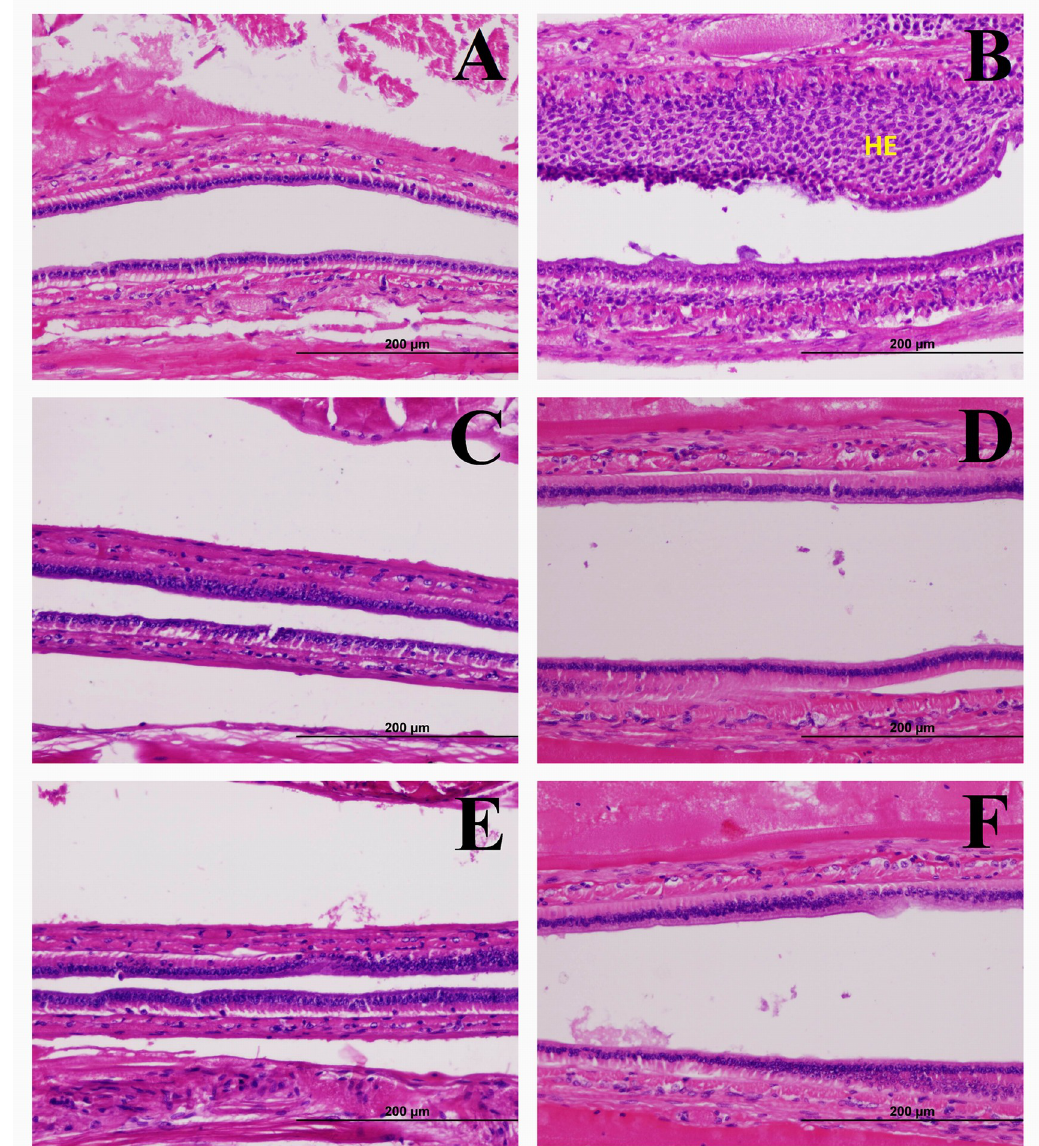
Fig 3. Effects of IQ extracts on histopathology of the intestine of the Vibrio parahaemolyticus -infected shrimp. Intestine of the shrimp fed the negative control diet ( A ), positive control diet showing hemocytic infiltration (HE) ( B ), IQ-E 200 mg/kg of feed diet ( C ), IQ-E 300 mg/kg of feed diet ( D ), IQ-WS 100 mg/kg of feed diet ( E ), and IQ-WS 150 mg/kg of feed diet ( F ) on day 14 after immersion challenge with Vibrio parahaemolyticus (10 3 CFU/mL) (H&E stain).